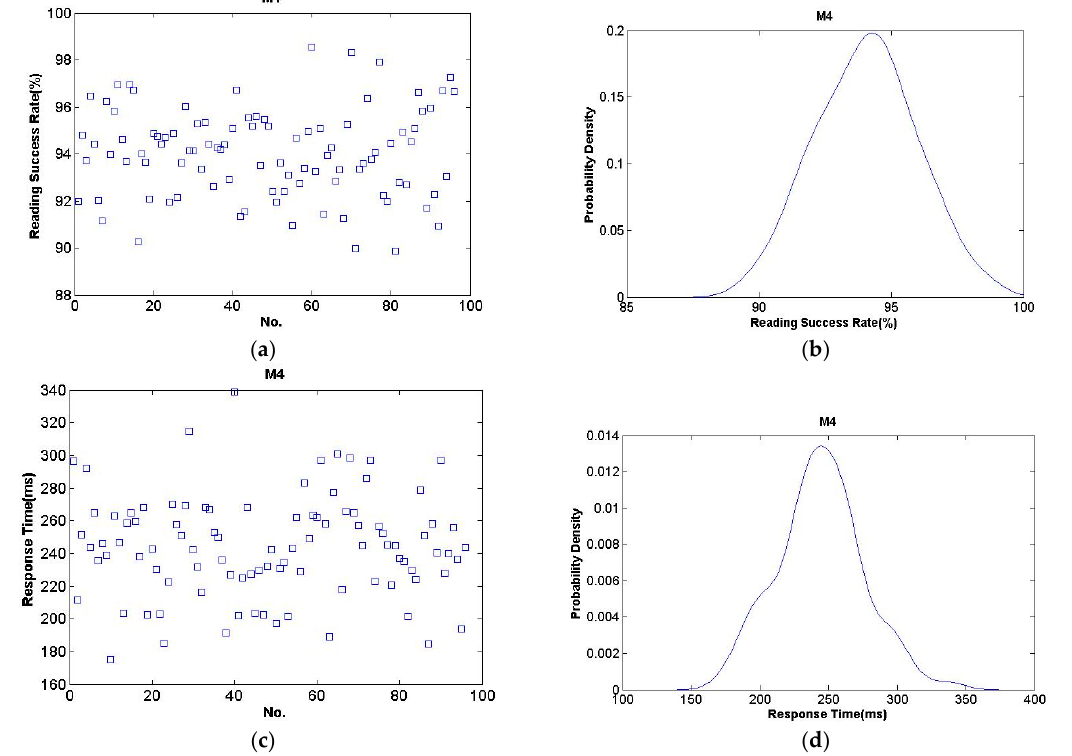
Figure 10. Measurements and PDs of M 4 . ( a ) Reading Success Rate; ( b ) PD of Reading Success Rate; ( c ) Response Time; ( d ) PD of Response Time.